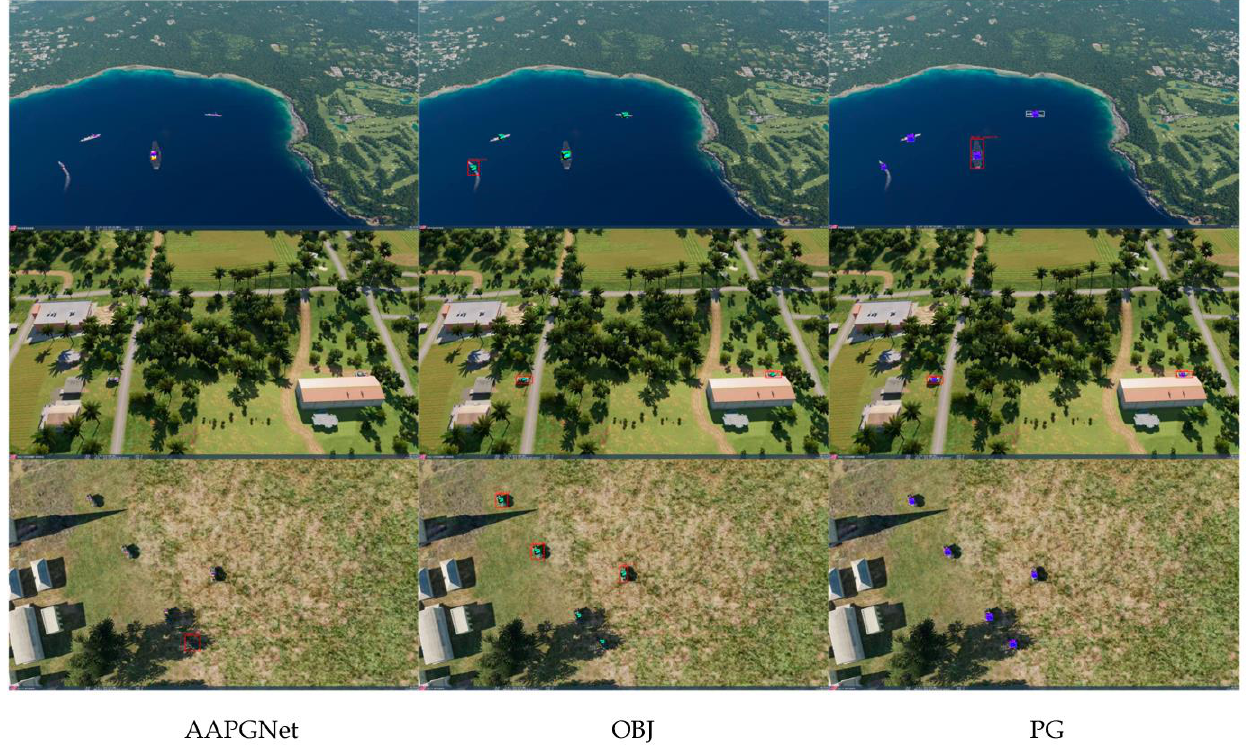
Figure 8. Visualized results of different attacking algorithms. The red box is the object’s bounding box, and the letters and the number on the top of the red box are the class name and the objectness.